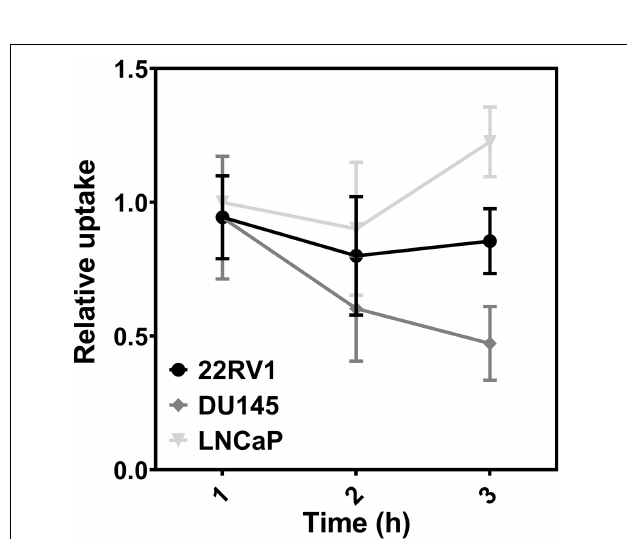
FIGURE 3 | Cellular uptake of 64 CuCl 2 in spheroids derived from human PCa cell lines. The cellular uptake was determined at 1, 2, and 3 h after the administration of 0.09–0.19 MBq of 64 CuCl 2 and uptake values were normalized to the mean area of the spheroids of each cell line and to the maximum uptake measured at 1 h (in LNCaP spheroids). Data are presented as the average ± S.E.M. of 3 independent assays.